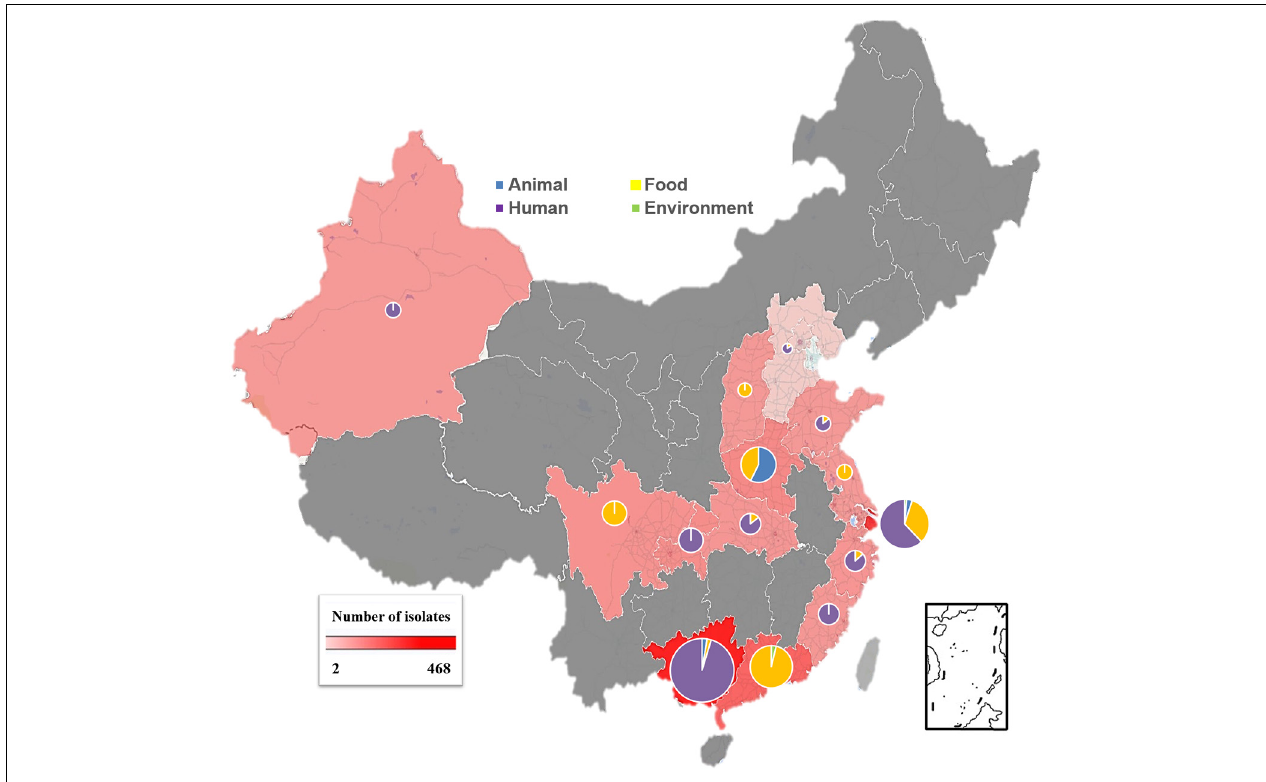
FIGURE 2 | Geographical distribution of S . Rissen isolates obtained from four established sources (humans, foods of animal origin, food animals, and environment) in China during 1995–2019. Pie charts reveal that the different sources for samples in each province and the size of charts is according to the actual number of the isolates obtained from each province. Blue color for animal samples, yellow color for food samples, green color for environmental samples and violet color human